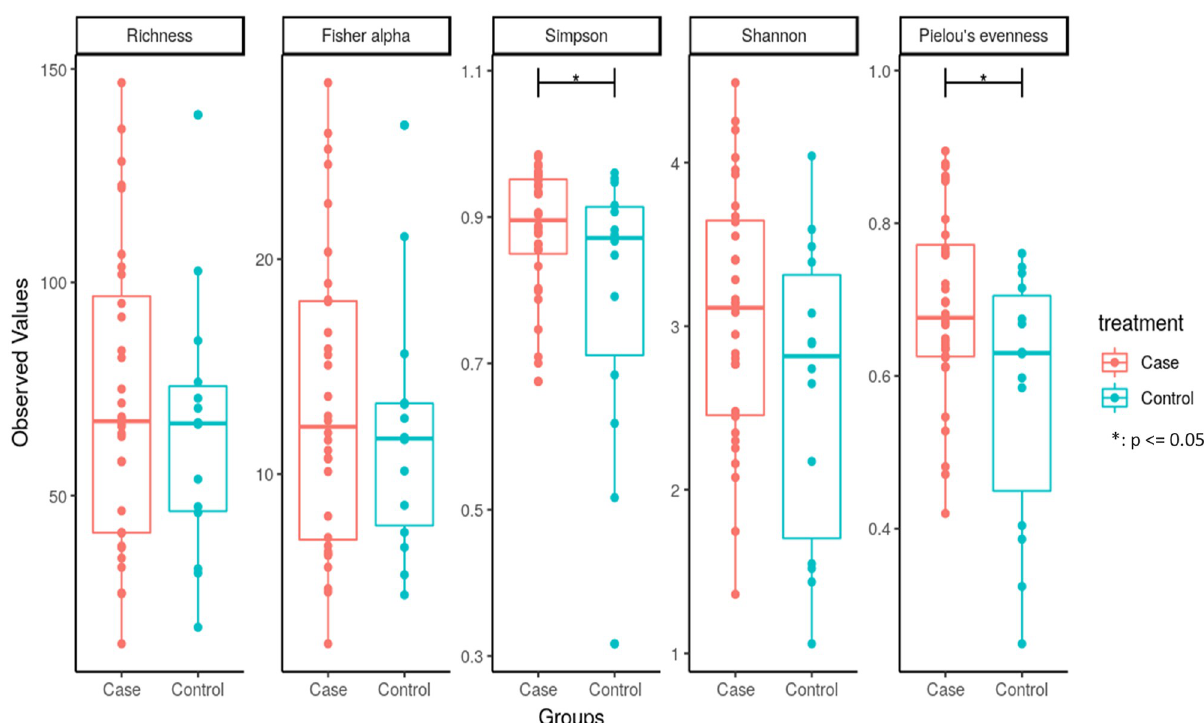
Fig 2. Alpha diversity of biliary microbiota in patients with benign vs malignant pancreaticobiliary diseases.